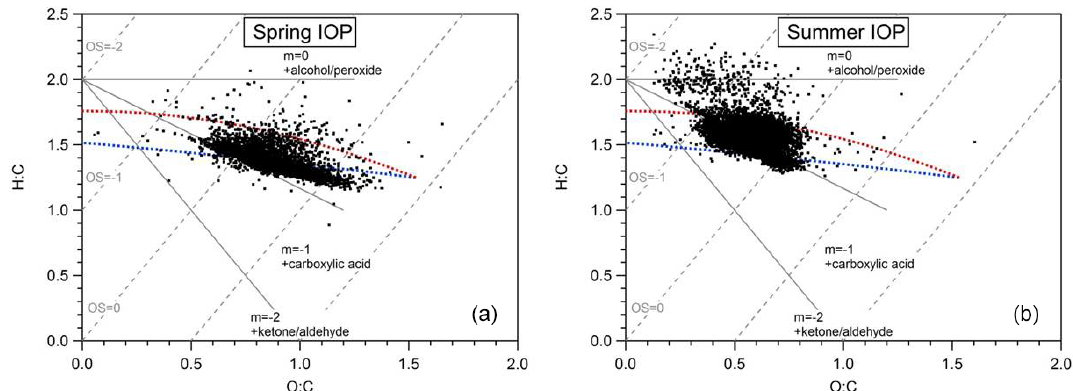
Figure 4. Van Krevelen diagrams of submicron OA observed at the SGP ground site during (a) the spring IOP and (b) the summer IOP. Linear regression analyses showed a slope of − 0 . 42 for spring IOP and − 0 . 54 for summer IOP.